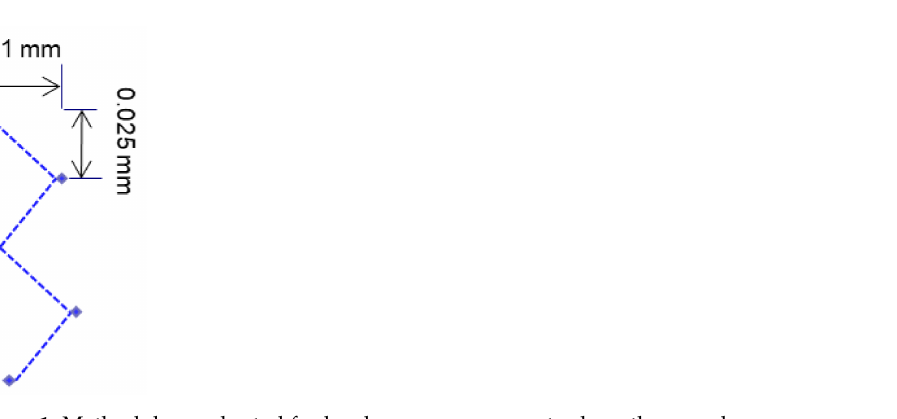
Figure 1. Methodology adopted for hardness measurements along the